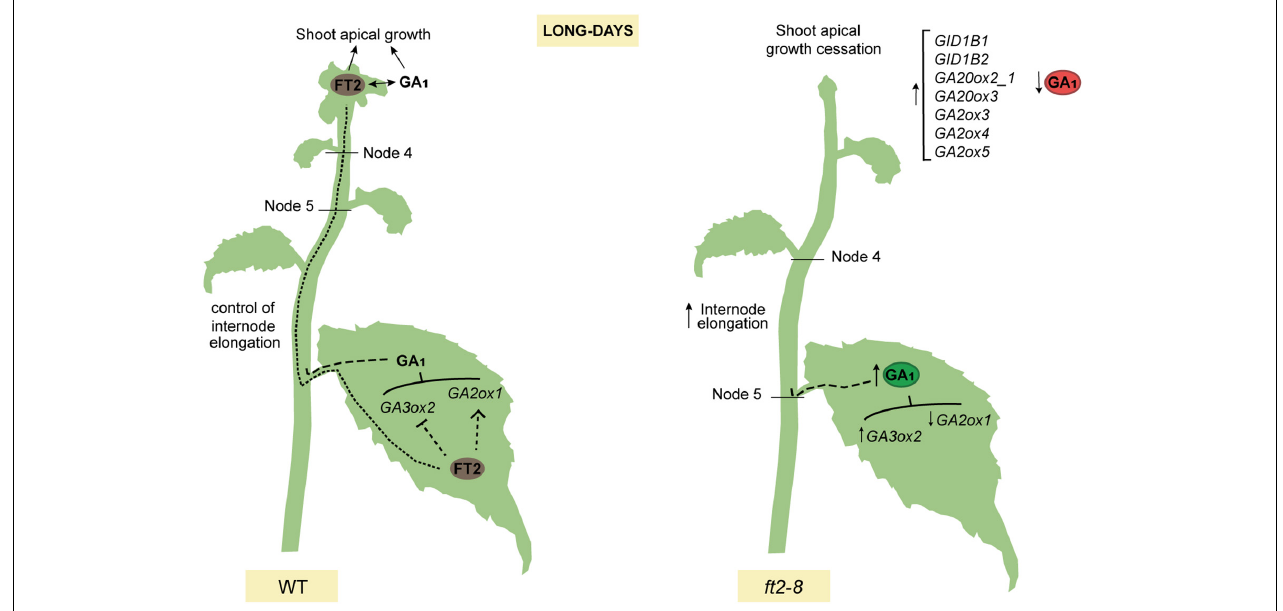
FIGURE 5 | Model showing that poplar FT2 modulates the 13-hydroxylation branch of the GA pathway to promote shoot apex development and restrict internode elongation. In WT plants ( left panel ), FT2 protein is synthesized in the leaf and moves to the shoot apex to promote development. FT2 is required to modulate expression of genes of the 13-hydroxylation branch of the GA pathway and GA 1 . We propose that leaf-derived GA limits internode elongation in stem. In shoot apex, FT2 is essential to modulate the expression of genes of the GA 13-hydroxylation pathway, to maintain levels of GA 19 , GA 20 , and GA 1 , and for shoot apex development. In contrast, in ft2-8 plants ( right panel ), the lack of FT2 causes an increase in leaf GA 1 levels, internode elongation, and a decrease in shoot apex GA 1